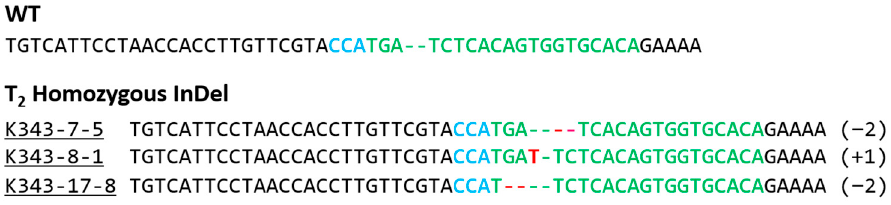
Figure 9. Identification of genotypes using NGS analysis in T 2 PUB7-GE. The minus ( − ) and plus (+) signs indicate the number of nucleotides deleted and inserted at the target sites, respectively. WT, wild type sequence with no mutations.